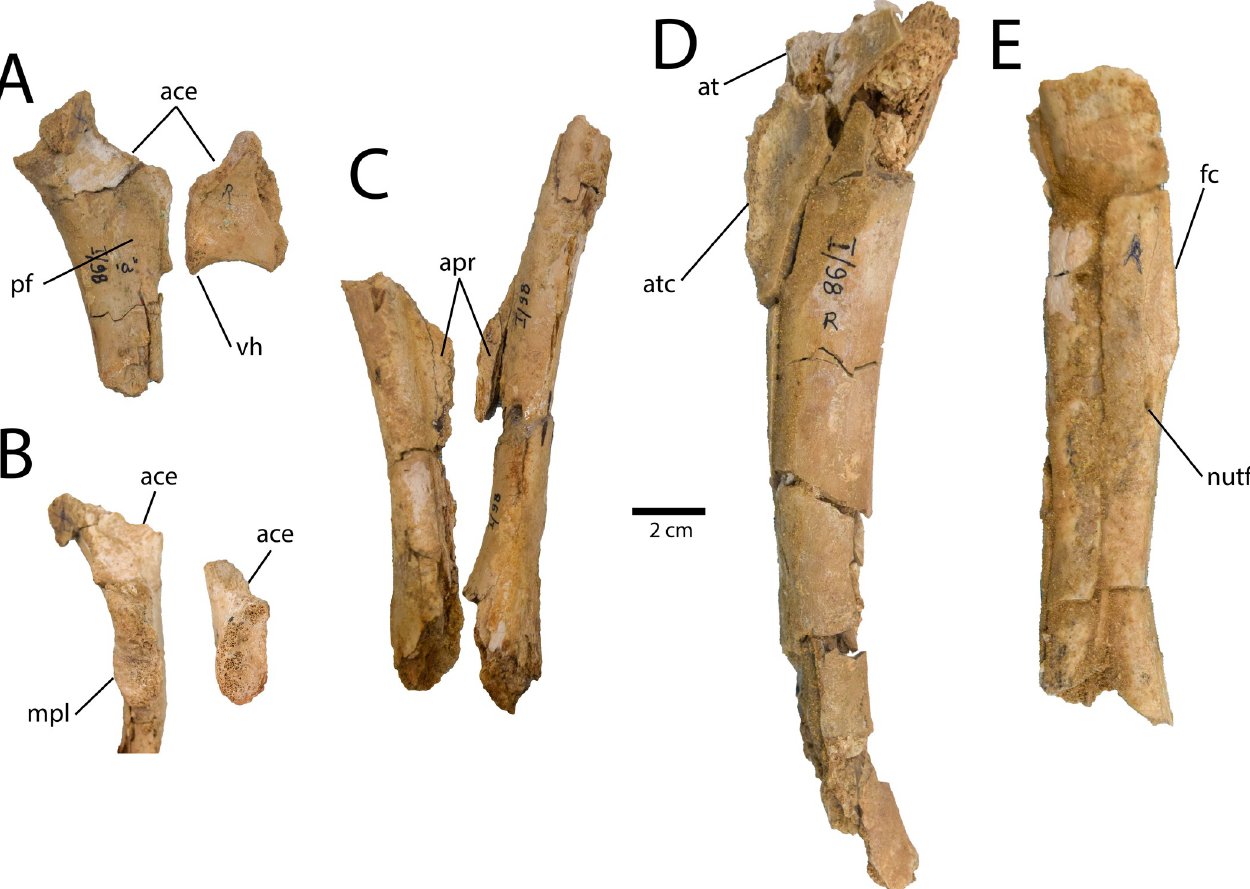
Fig 7. Additional elements of Elmisaurus rarus (ZPAL MgD I/98) after further preparation. A , B, Right proximal pubis (left) and ischium (right) in medial (A) and posterior (B) views. C , left and right pubic shafts in posterior view. D , right femur in medial view. E , right tibia shaft in posterior view. Abbreviations: ace , acetabulum; apr , pubic apron; at , anterior trochanter; atc , accessory trochanteric crest; fc , fibular crest; mpl , medially protruding lip; nutf , nutrient foramen; pf , pubic fossa; vh , ventral